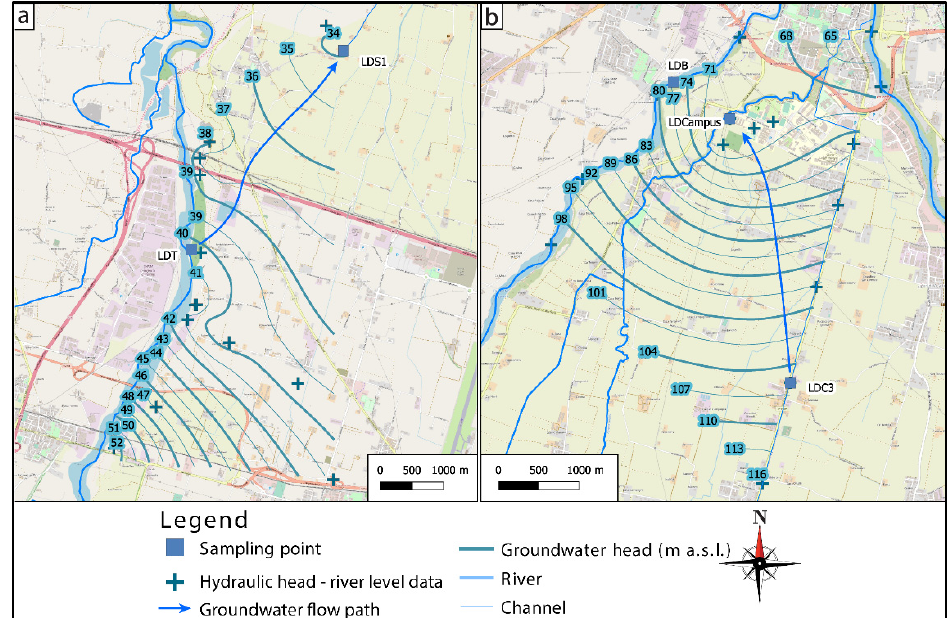
Figure 3. Groundwater net for the subareas. ( a ) Groundwater flowpath between LDT and LDS1, hydraulic head data from Lancini [32]; ( b ) groundwater flowpath between LDC3 and LDCAMPUS, hydraulic head data from Viani [31]. Table 1. Isotopic and field data. The dot represents not-analyzed samples.